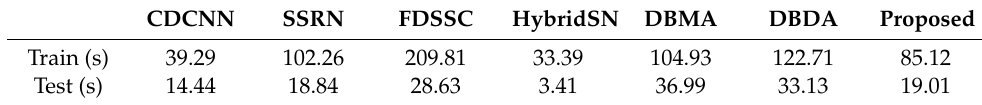
Table 12. The training time and test time in seconds (s) for different methods on the PU dataset. CDCNN SSRN FDSSC HybridSN DBMA DBDA Proposed